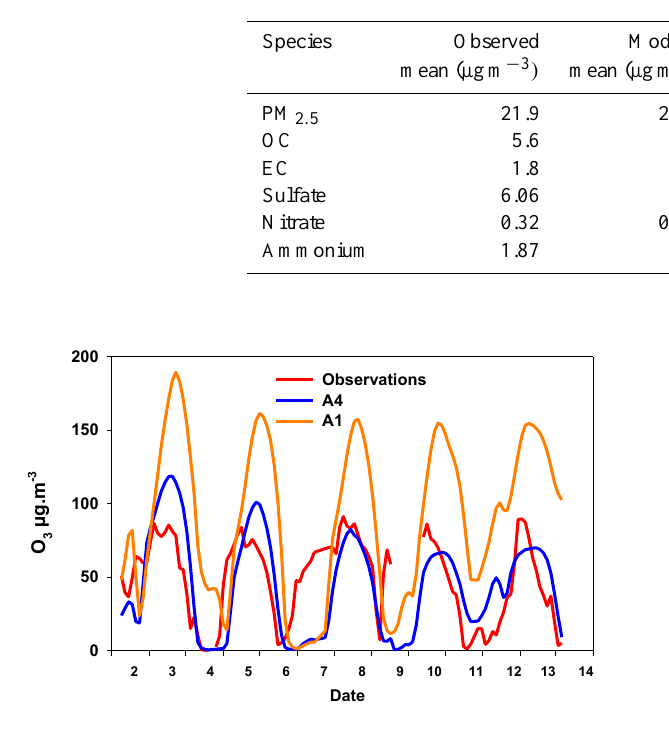
Figure 6. Temporal variation of observed and modeled O 3 concentrations in µg/m 3 from July 2 2 Fig. 6. Temporal variation of observed and modeled O 3 concentra- tions in µgm − 3 from 2 to 13 July 2011.